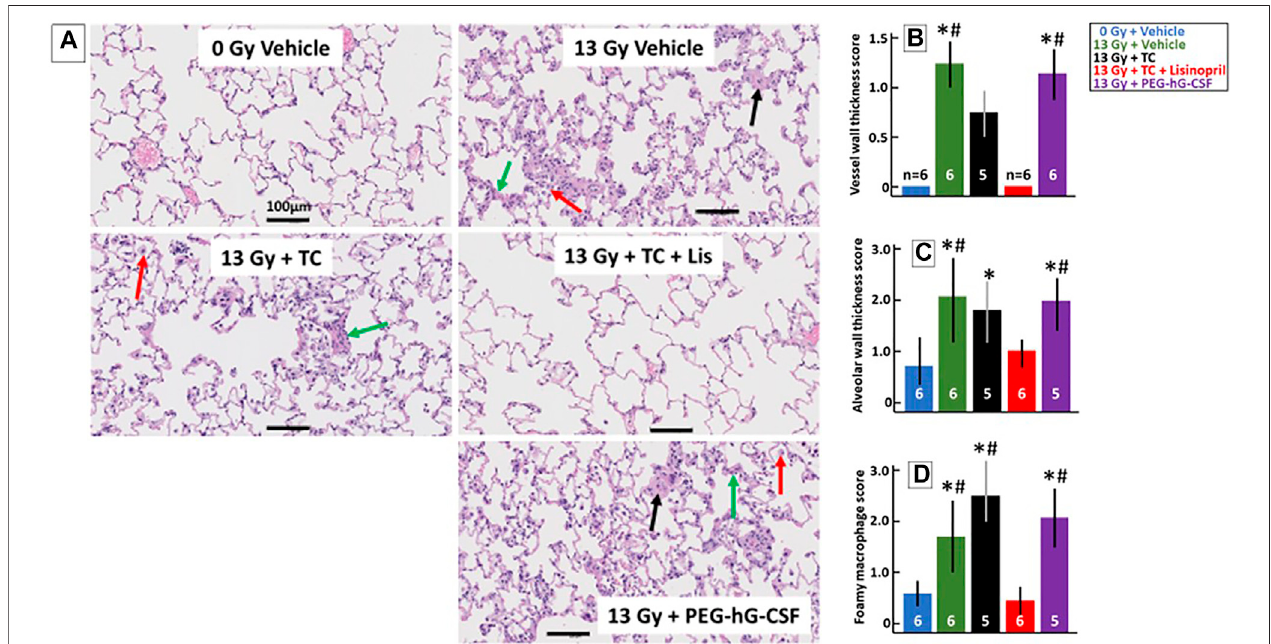
FIGURE 6 | Lisinopril mitigates histological lung injury after 13 Gy leg-out PBI. Representative histological sections of lung tissue harvested at 56-days after 13 Gy leg-out PBI were stained with H&E for each treatment group (A) . Irradiated rats given the vehicle or PEG-hG-CSF showed increased alveolar wall thickness cellularity (green arrow), increased vessel wall thickness (black arrow) and foamy macrophages (red arrow). Black bars represent 100 μ m. Graphical representations of the H&E- stained lung sections are shown for vessel wall thickness (B) , alveolar wall thickness (C) and foamy macrophages (D) . Vessel wall thickness (B) were increased in irradiated rats given the vehicle or PEG-hG-CSF, whereas TC + lisinopril mitigated lung injury ( p < 0.05, denoted by * compared to controls and # compared to TC + lisinopril).Irradiationincreasedalveolarwallthickness (C) inallirradiatedgroupscomparedtocontrol( p < 0.05,denotedby*)exceptfortheTC+lisinoprilgroup.Alveolar wallthicknesswasalsoincreasedcomparedtotheTC+lisinoprilgroupintheirradiatedvehicleandPEG-hG-CSFgroups( p < 0.05,denotedby#).Foamymacrophages (D) were signi fi cantly increased in irradiated rats given the vehicle, TC or PEG-hG-CSF ( p < 0.05, denoted by * compared to controls and # compared to TC + lisinopril). Numbers in the bars represent N in each group and bars are means with standard